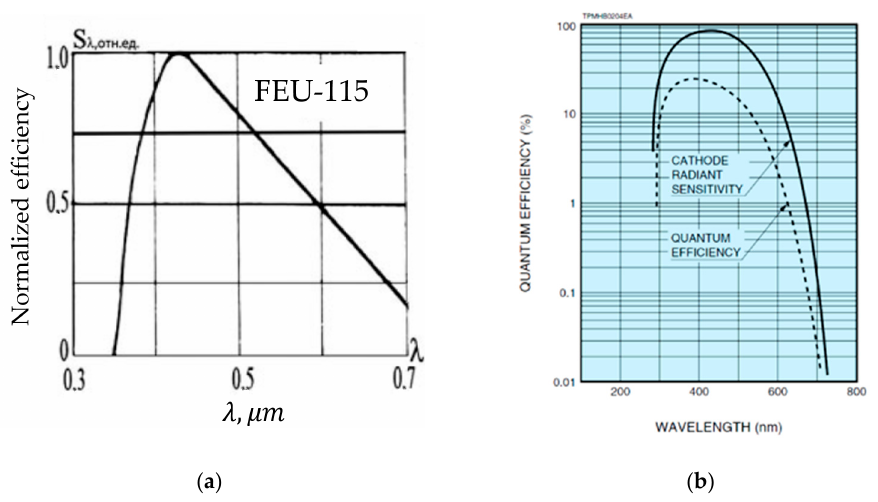
Figure 2. Detection efficiency vs. wavelength for: ( a ) FEU-115 PMT, ( b ) R580 PMT.